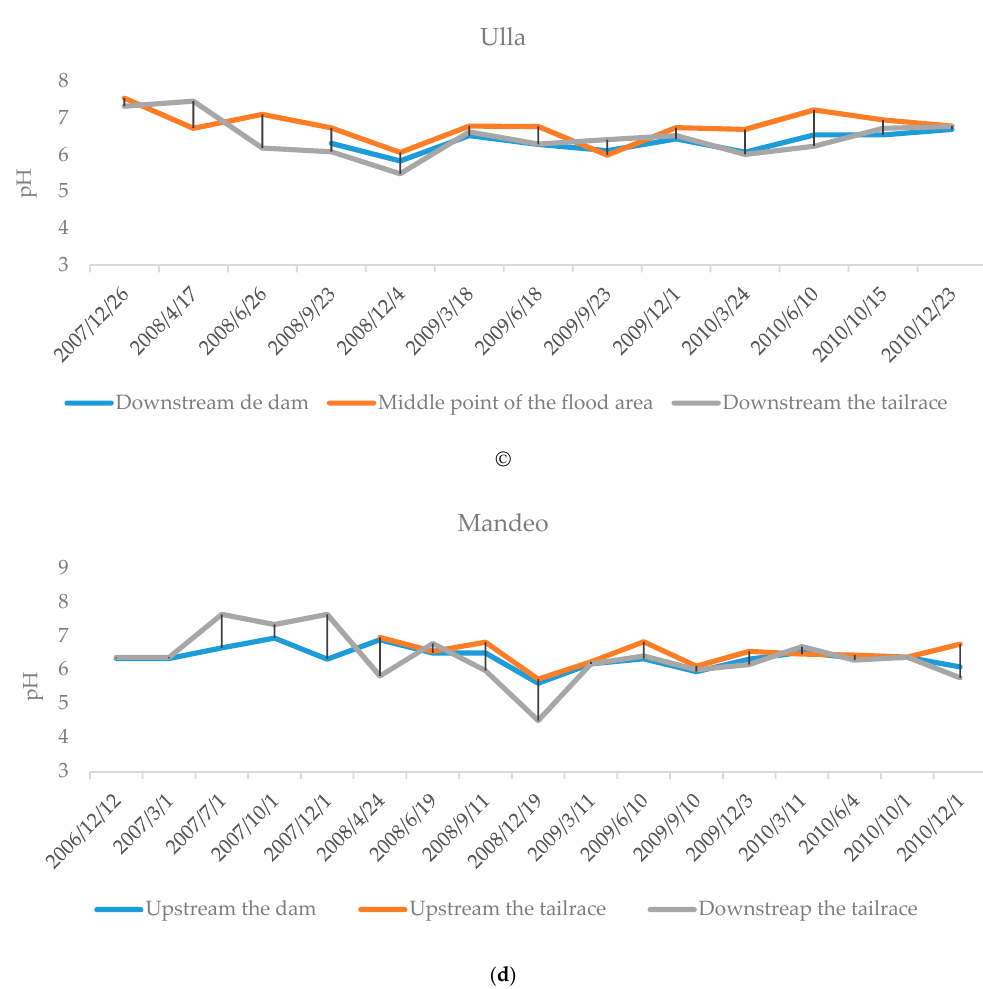
Figure 3. Temperature values measured during the survey period at ( a ) Lerez (San Xusto plant), ( b ) Umia (Hermida plant), ( c ) Ulla (Touro plant) and ( d ) Mandeo (Gomil plant).